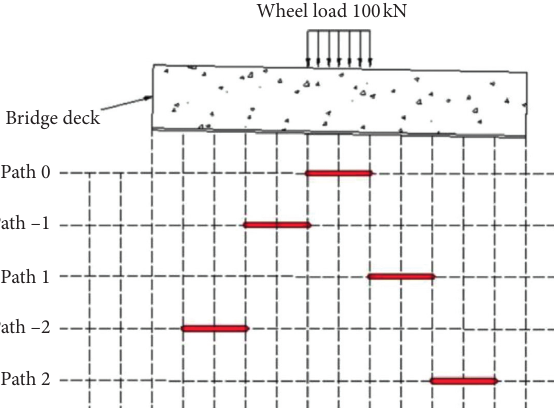
Figure 14: Lateral loading position of the wheel.